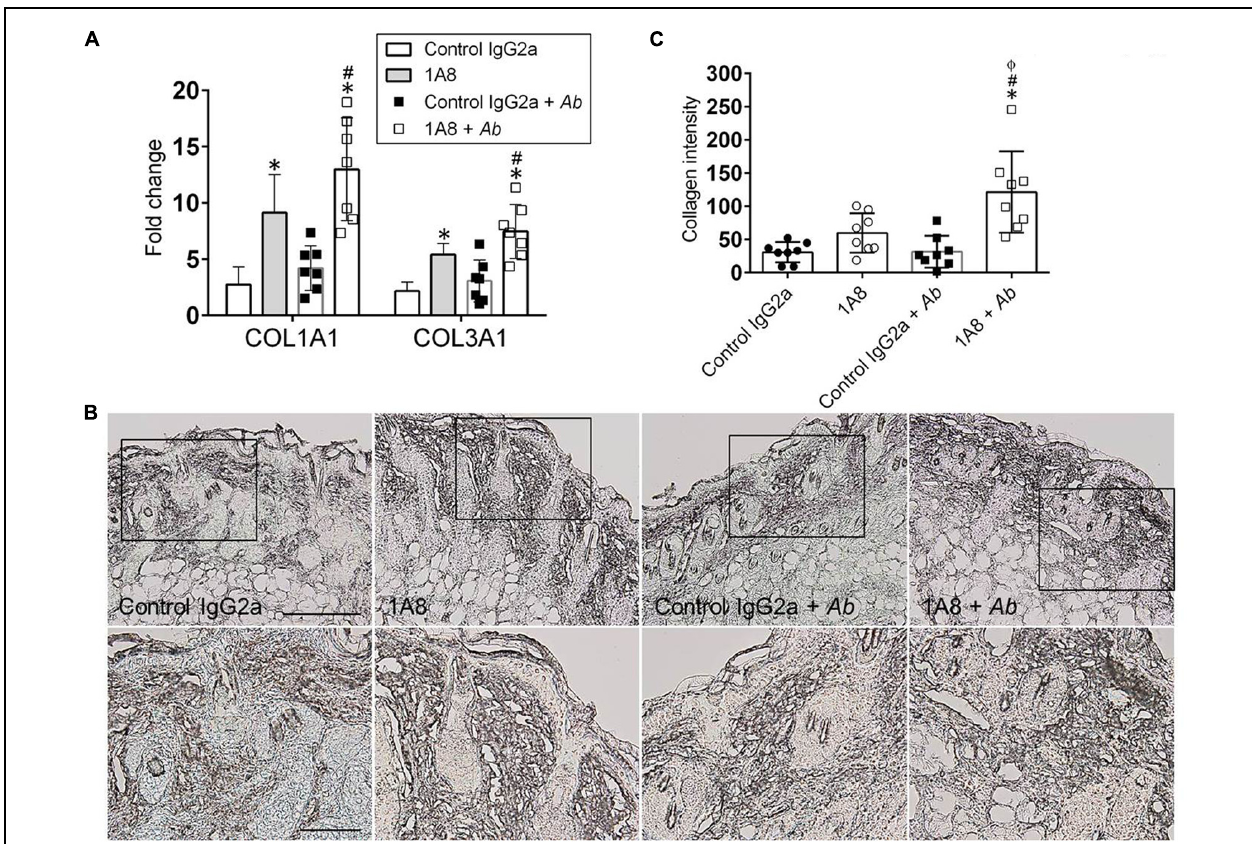
FIGURE 3 | Neutropenia promotes collagen deposition in cutaneous lesions of rodents. (A) Gene expression analysis of collagen type I (COL1A) and III (COL3A) in murine dermal tissue. For control and 1A8 uninfected animals, bars are the averages of the results for five wounds, and error bars denote standard deviations. For control IgG2a- and 1A8-infected with A. baumannii groups, bars are the averages of results for seven clinical isolates (each symbol represent a strain; n = 7) and error bars denote standard deviations. ∗ and # indicate higher fold changes than control and A. baumannii groups, respectively. (B) IHC of collagen type I produced in wounds of isotype-matching mAb-treated (control IgG2a), mAb 1A8-treated (1A8), control IgG2a-treated A. baumannii -infected (control IgG2a + A. baumannii ), and mAb 1A8-treated A. baumannii -infected (1A8 + A. baumannii ) Balb/c mice, 7 days post-infection. Representative 20X (upper panel) and 40X (lower panel; magnified black boxes in upper panel) collagen type I-immunostained sections of the skin lesions are shown. The dark staining indicates collagen. Scale bar: 20 μ m. (C) Quantitative measurement of collagen type I intensity in eight representative fields (each symbol) of the same size for control IgG2a, 1A8, control IgG2a + A. baumannii , and 1A8 + A. baumannii wounds. Data are given as the average of the results, and error bars denote standard deviations. ∗ , #, φ indicates higher levels than control IgG2a, 1A8, A. baumannii groups, respectively. For (A,C) , P -value significance ( P < 0.05) was calculated by ANOVA. Each experiment was performed twice and similar results were